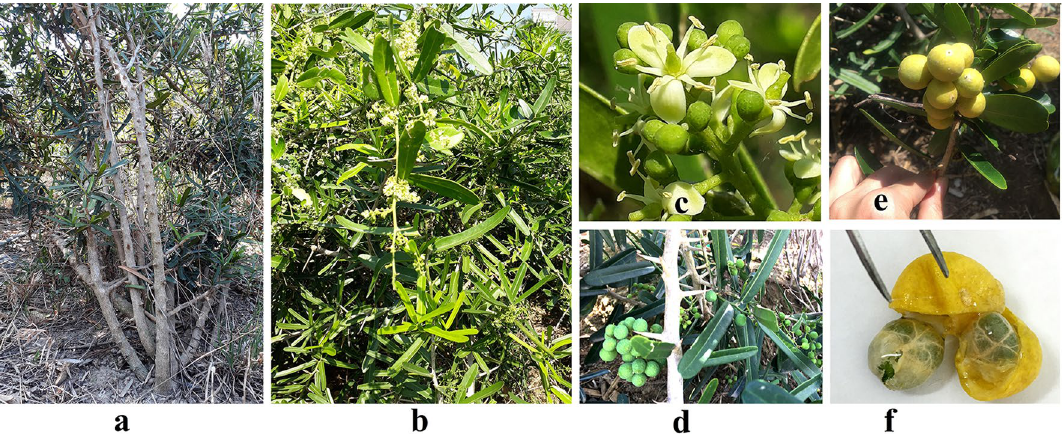
Figure 2. The typical morphology and anatomy of Paramignya trimera (Oliv.) Burkill. Woody shrub 1–4 m or above ( a ); A flowering tree ( b ); Typical trimerous flowers ( c ); Green fruits ( d ); Ripen fruits ( d ); Opened ripen fruit with two seeds encapsulated by mucus endocarp ( e